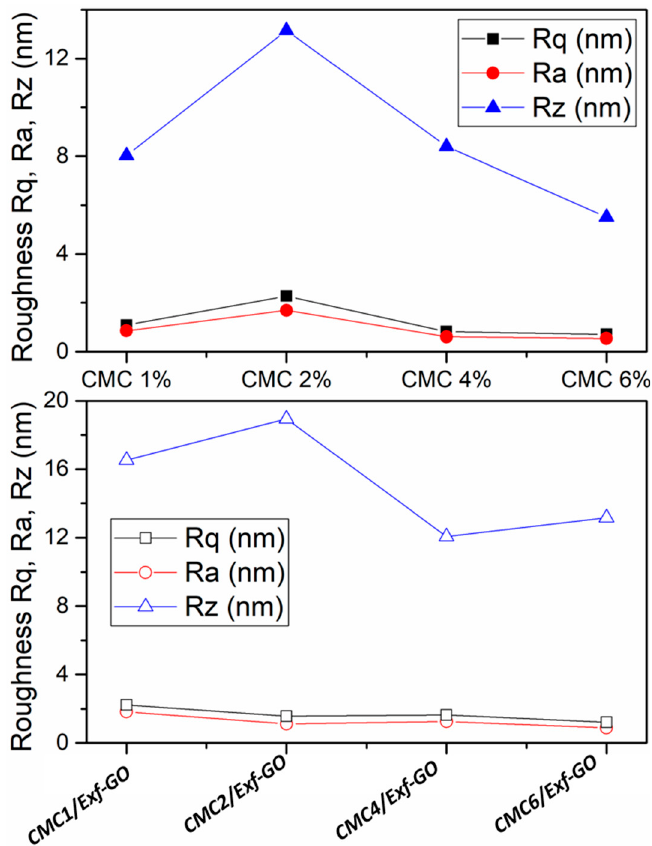
Figure 5. Roughness Rq, Ra and Rz for the CMC samples (upper figure, close symbols) and CMC6 / Exf -GO samples (lower figure, open symbols), where: Rq is the root-mean-squared roughness; Ra is the roughness average; and Rz is the ten-point average roughness.